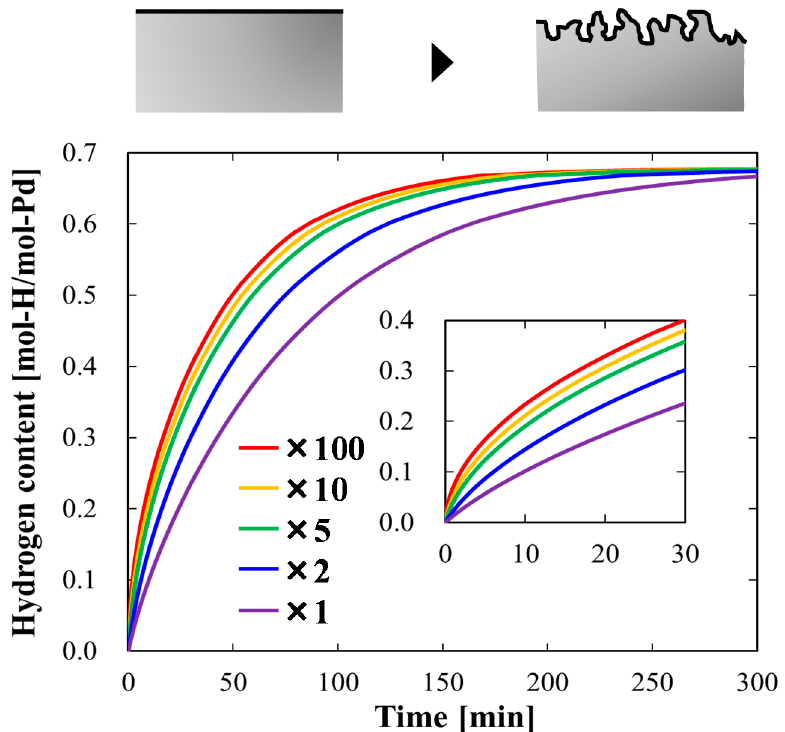
Figure 4. Simulated time evolution plots of hydrogen content absorbed in Pd plates of various effective surface areas, which were 1, 2, 5, 10, and 100 times larger than that of the smooth surface Pd. The inset depicts a magnified view for the first 30 min of the hydrogen absorption process. The accompanying schematic (top) is a conceptual drawing of the surface roughening process.